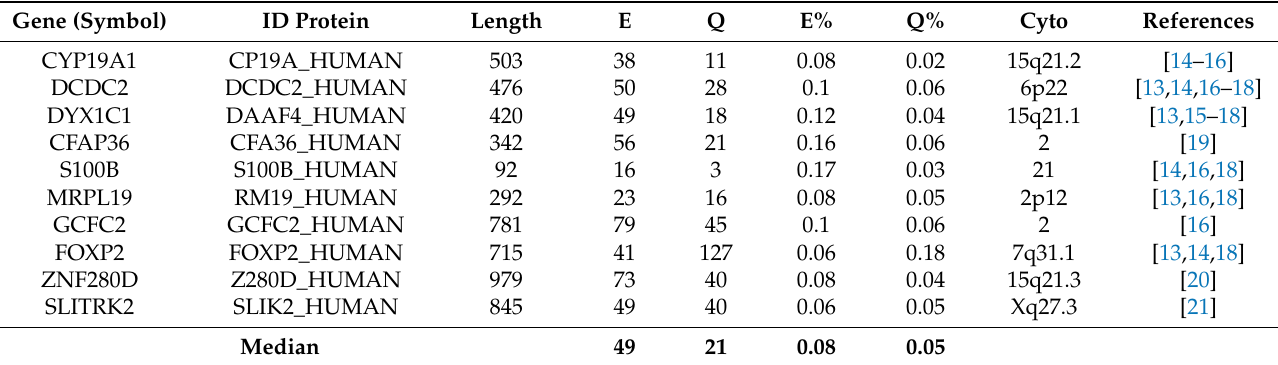
Table 2. Median values of selected amino acids calculated in protein markers of dyslexia as absolute content or relative frequencies (% of the total). Cytogenetic location of markers is indicated (Cyto).